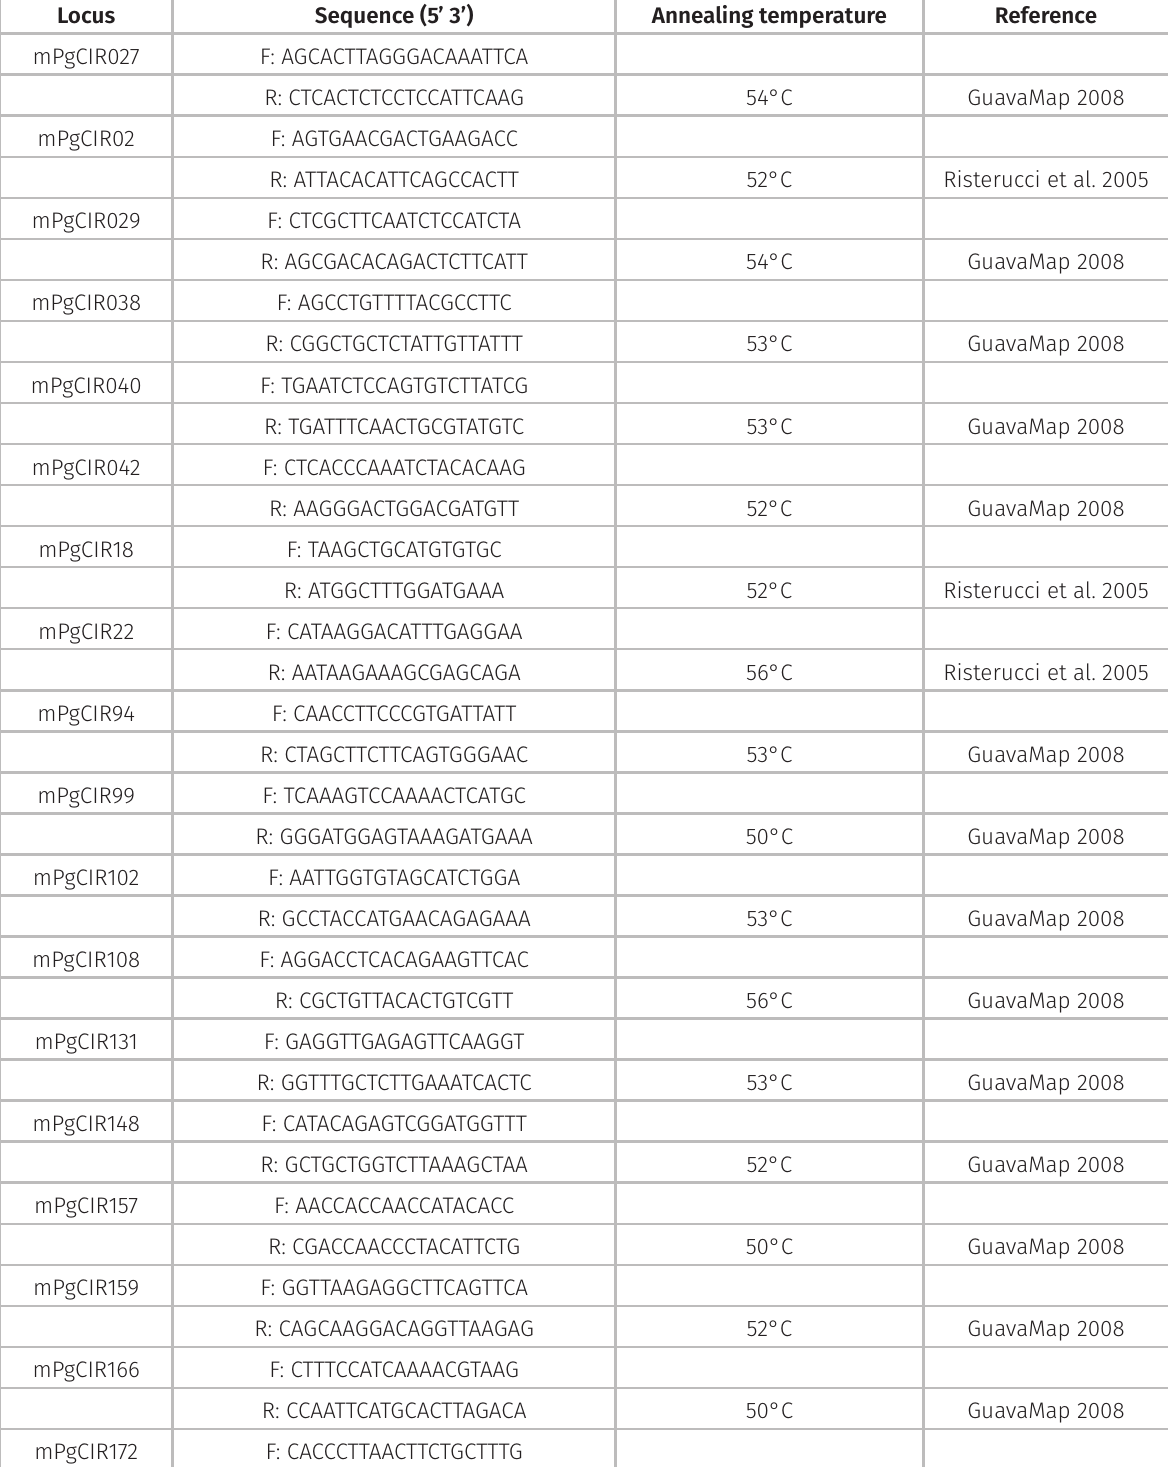
Table II. Sequence of the 33 pairs of microsatellite primers used in the analysis of the 94 genotypes originating from five populations obtained from interspecific crosses of Psidium